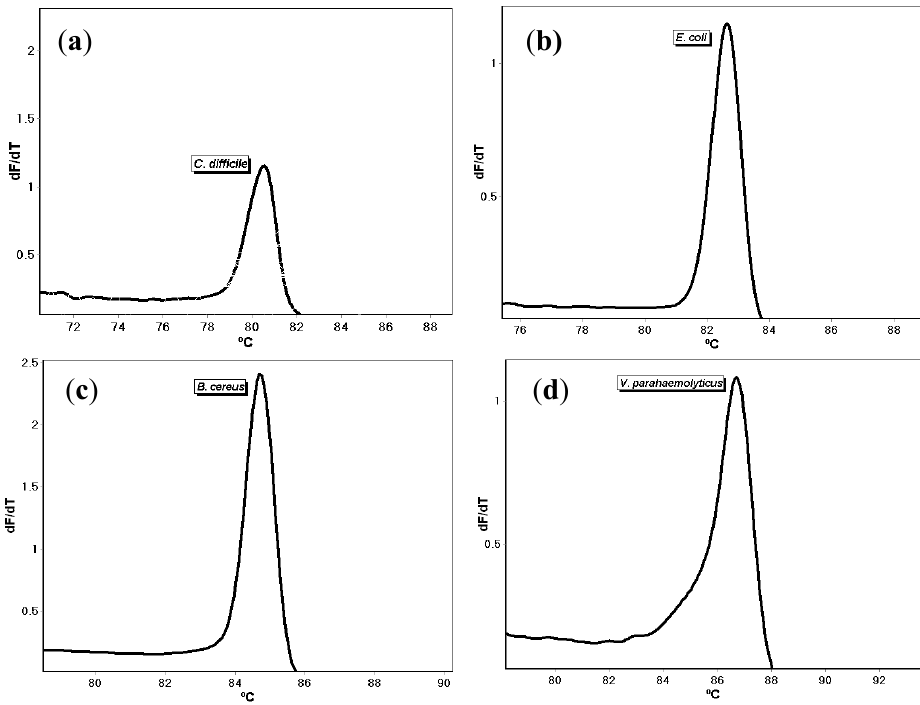
Figure 1. Single melt curves using individual primer set for: ( a ) C. difficile; ( b ) E. coli; ( c ) B. cereus; and ( d ) V. parahaemolyticus.